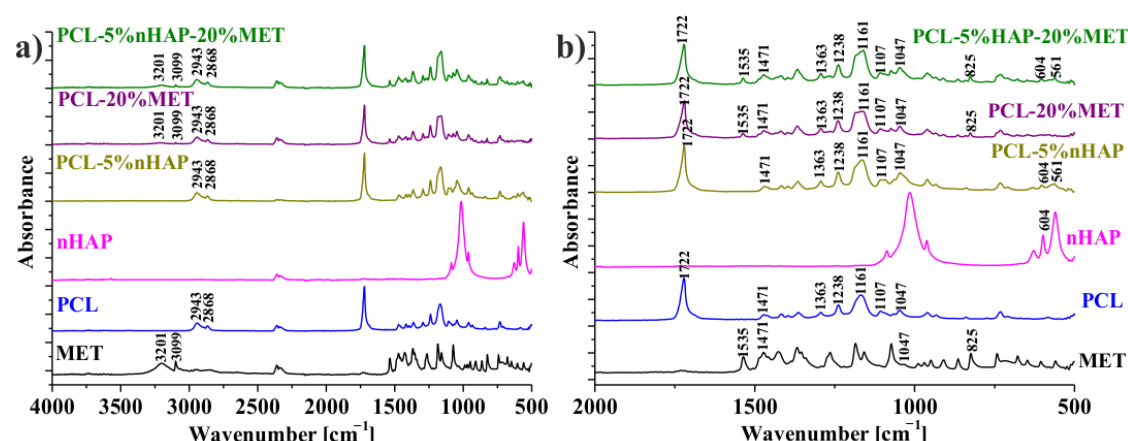
Figure 6. FTIR spectra of nHAP, MET, PCL, PCL-5% nHAP, PCL-20% MET and PCL-5% nHAP-20% MET: ( a ) FTIR spectrum